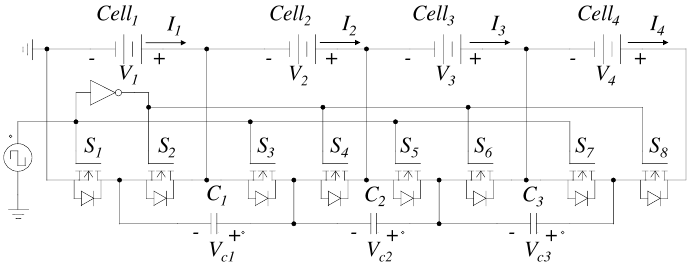
Figure 9. Switched capacitor topology